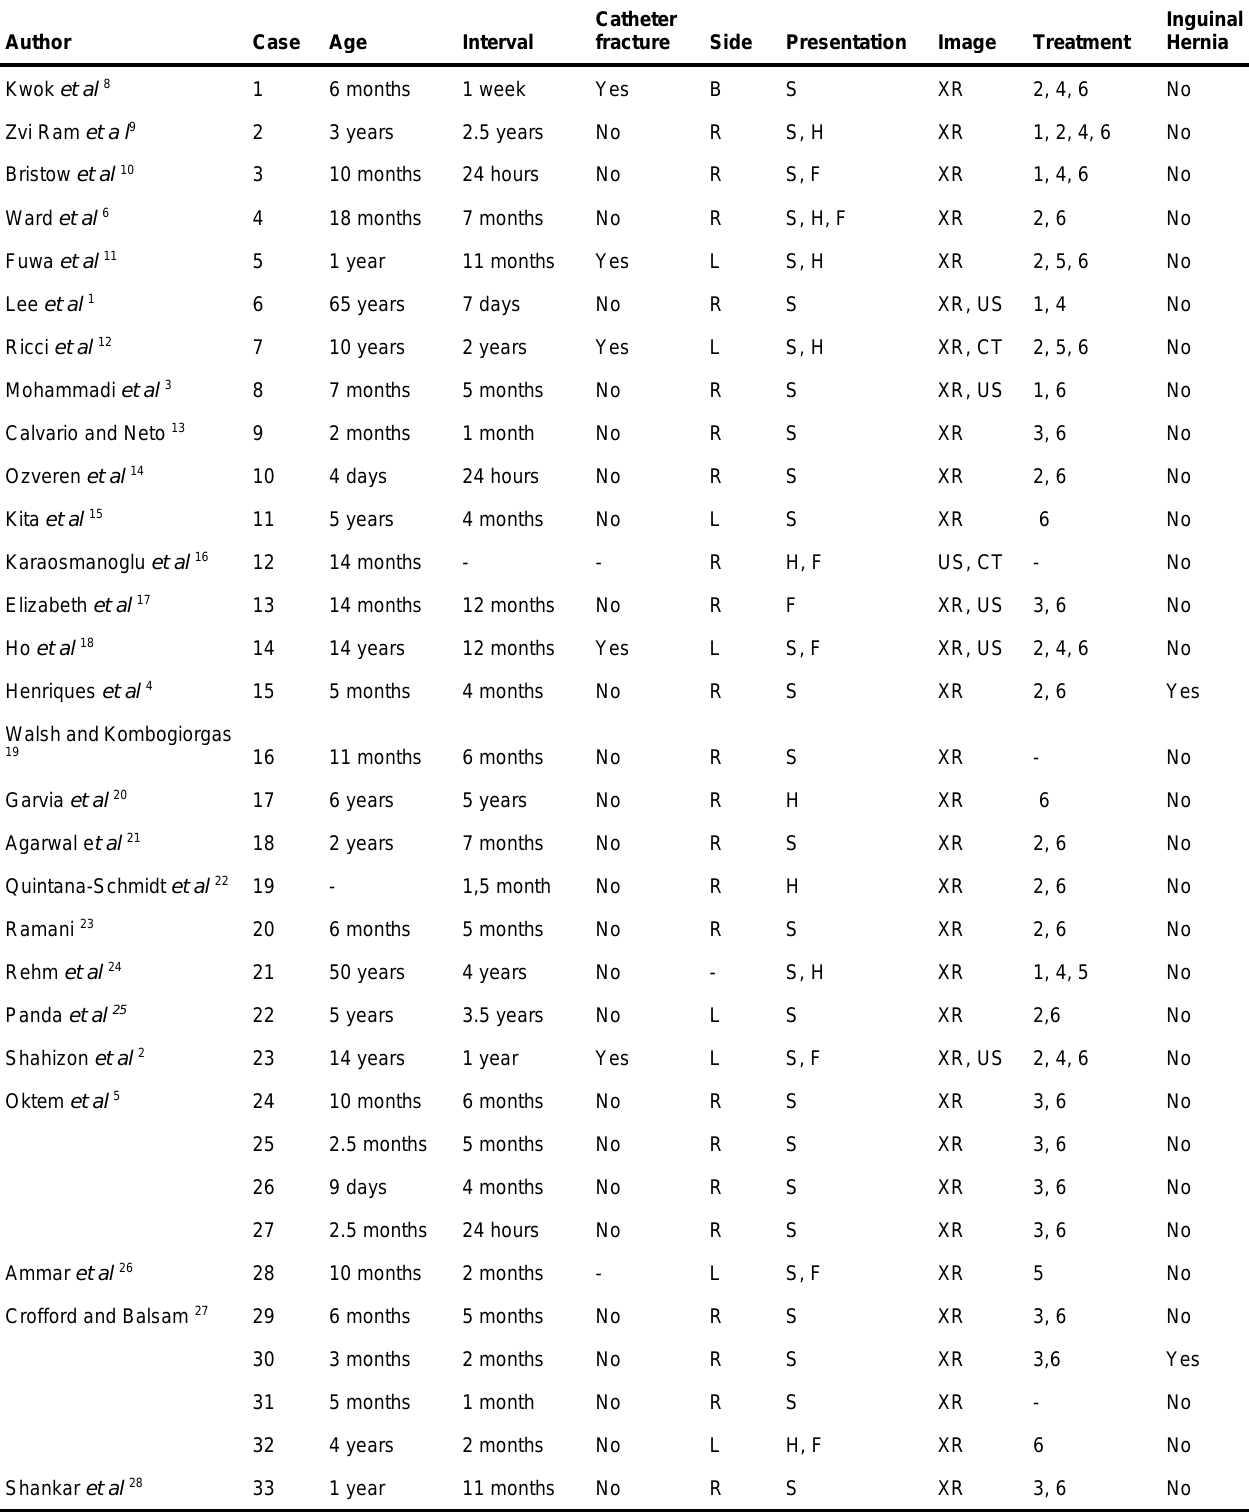
Table 1. Summary of previous reported cases of VPS scrotal migration